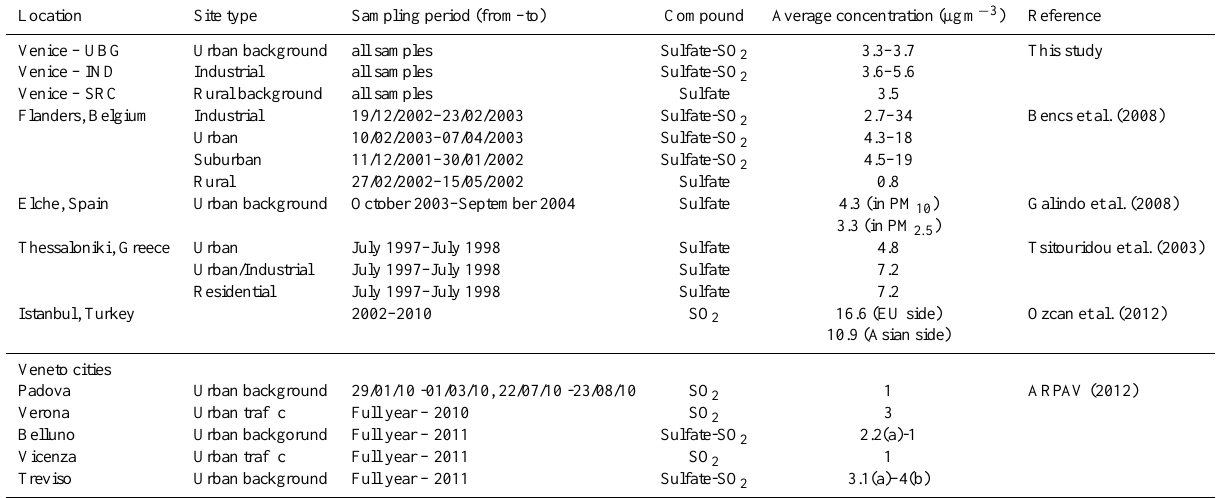
Table 4. Comparison between SO 2 and sulfate concentration detected in this study and in other areas. (a) Sulfate concentration values have been provided by ARPAV – Regional Service Laboratories; (b) SO 2 concentration values have been provided by ARPAV – Department of Treviso.